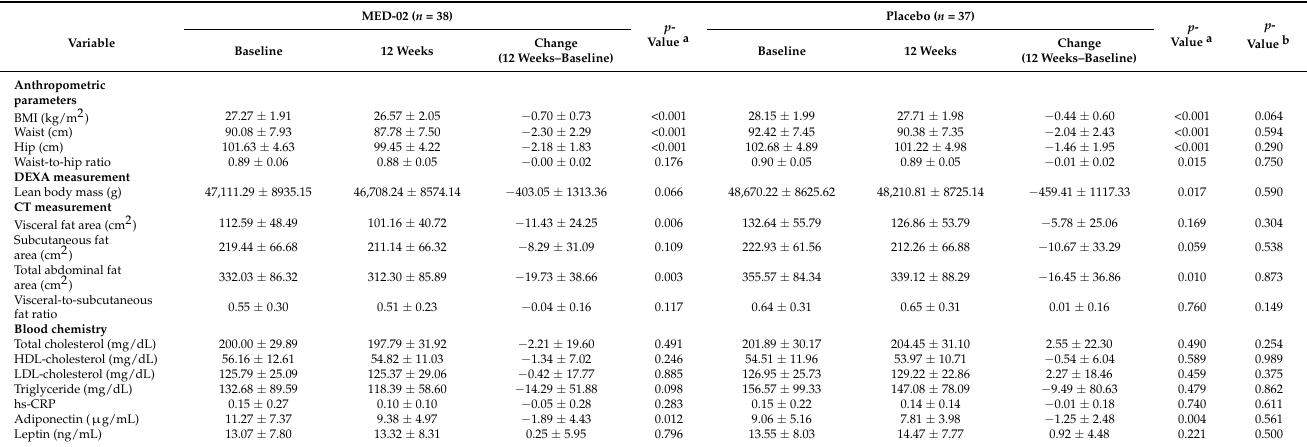
Table 2. Anthropometric parameters and blood chemistry of subjects before and after 12-week placebo and consumption of probiotics